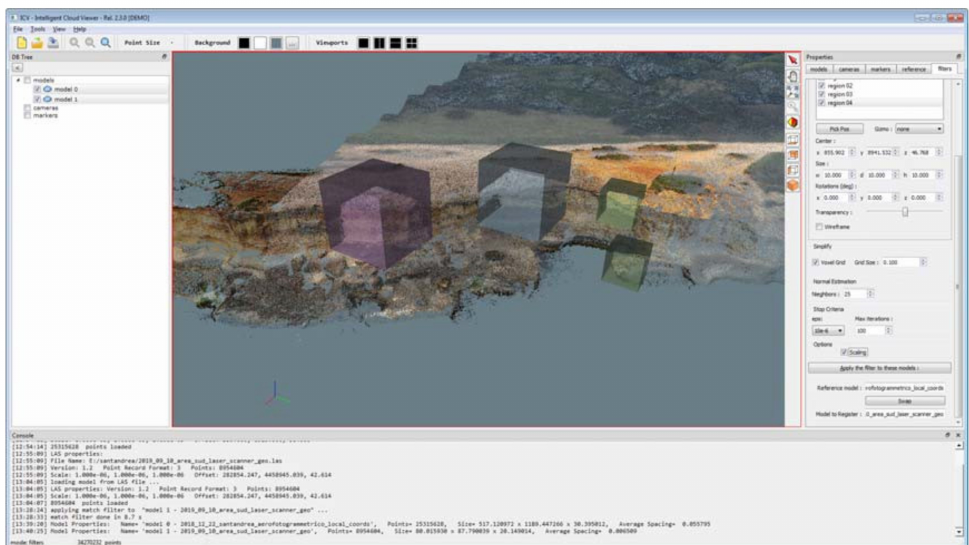
Figure 11. Detection of bounding boxes on models.